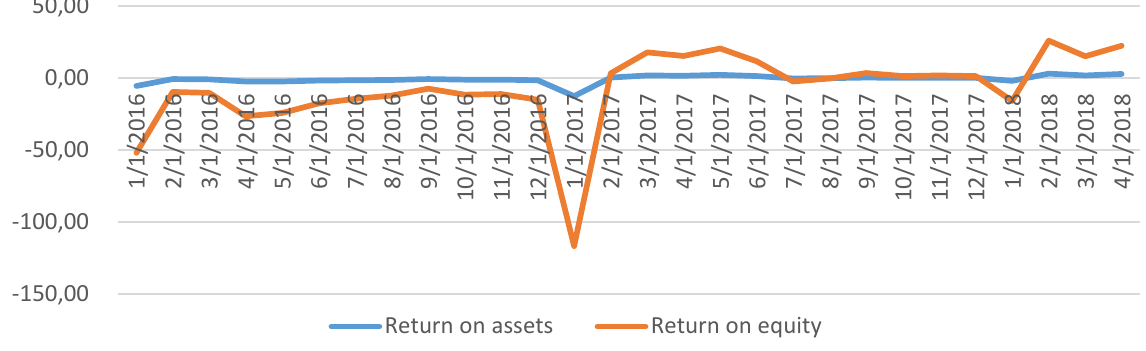
Figure 1. Dynamics of return on assets and return on equity of Ukrainian banks in 2016–2018,